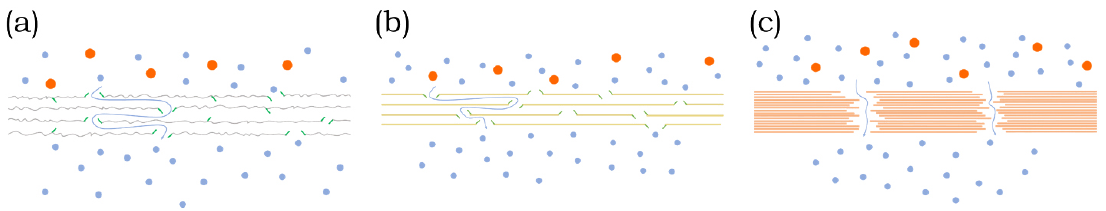
Figure 4. Stacking structure of laminar membranes that reject pollutants and yet allow water to pass, illustrated as red and blue circles, respectively. The water pathways are indicated by blue arrows. ( a ) Corrugated GO membrane with functional groups highlighted in green and located at the nanosheet (grey) edges and on the surface. ( b ) Transition Metal Dichalcogenides (TMD) membrane with functional groups highlighted in green are located at the nanosheet (yellowish) edges and in the rigid nanostructure. ( c ) Niobate membranes with small interlayer spacing and vertical separation due to pore